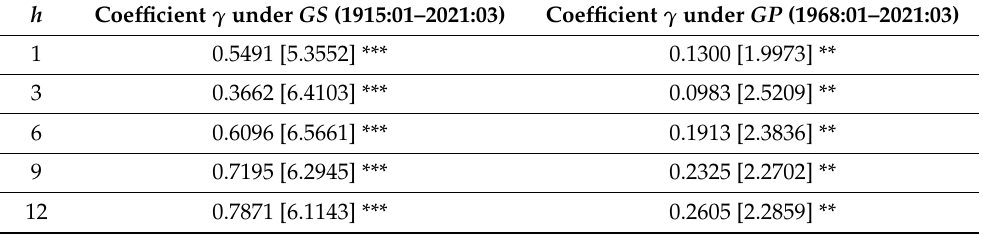
Table 1. In-Sample